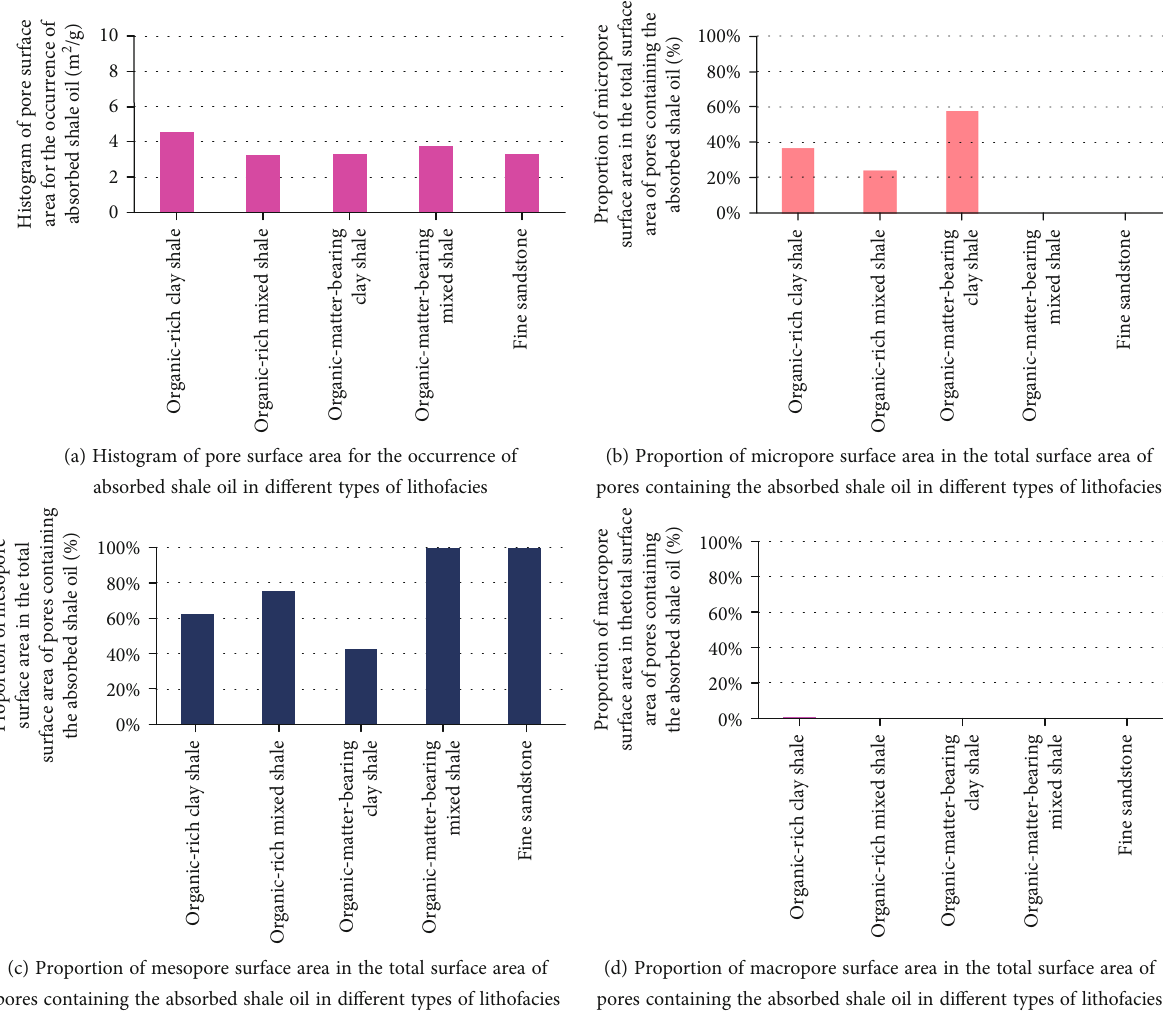
Figure 7: Pore surface area characteristics for the occurrence of absorbed shale oil in di ff erent types of lithofacies in TY1